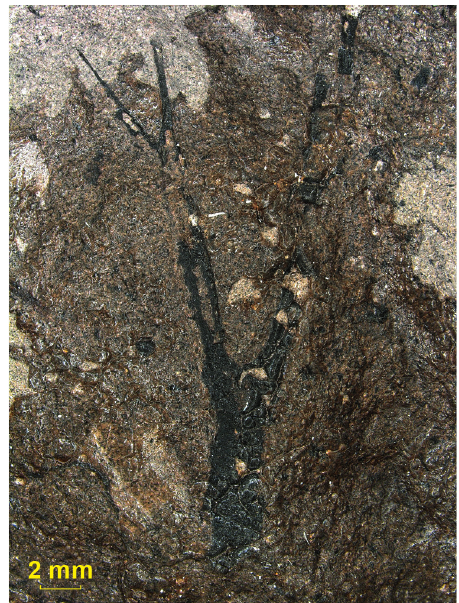
Figure 11. Possible juvenile leaf, sample 28, Mt